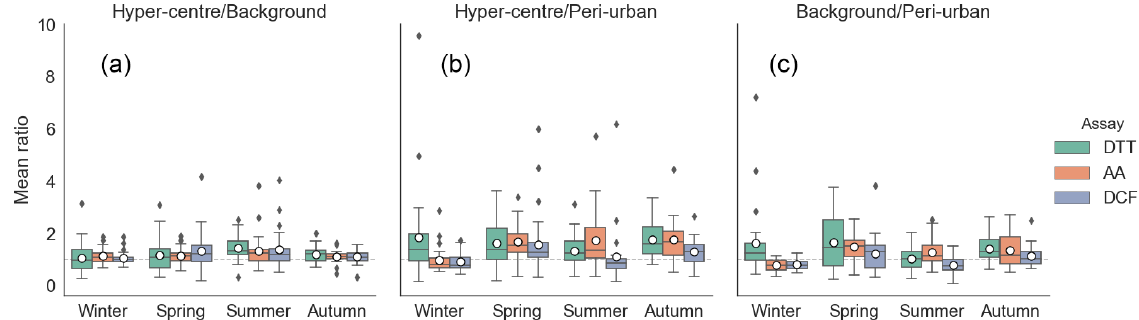
Figure 3. Seasonal mean ratios (MR) between the sites (a) hyper-centre / background (UH / UB), (b) hyper-centre / peri-urban (UH / PU), and (c) background/peri-urban (UB / PU) using volume-normalized OP activities (OP DTT v , OP AA v , and OP DCFH v ). Dashed grey line denotes MR equal to 1, suggesting total spatial homogeneity. Boxplot mean marked by white circle and median marked by black line.